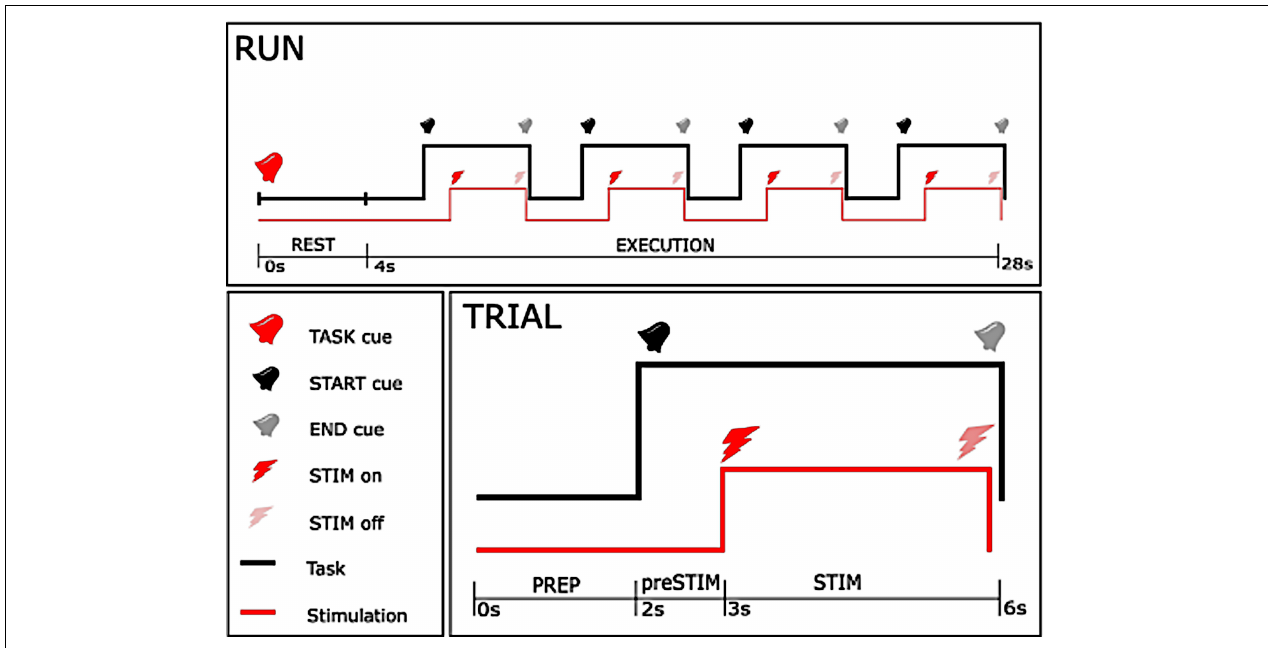
FIGURE 1 | Time-course of the experiment. The upper figure shows the time-course of each single run, with the lower right figure showing the course of a single trial. As can be seen from the upper plot, a 24 s execution period with one specific instruction (either rest or motor imagery) started after a 4 s rest period, and consisted of 4 trials. In each trial, stimulation started 1 s after the start cue, and stopped 3 s later concurrently with the end cue with 2 s between